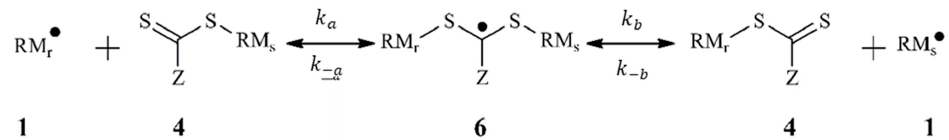
Figure 2. Reversible chain transfer to the RAFT agent (pre-equilibrium).